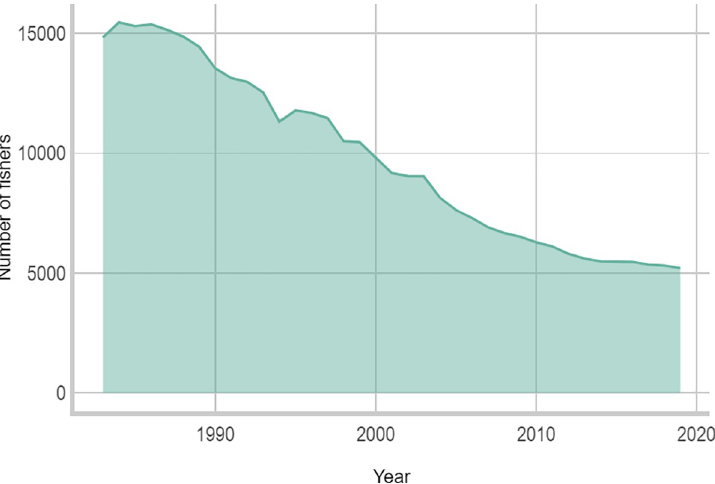
Fig 2. Number of fishers. The number of registered fishers in Northern-Norway (1983–2019) (Data source: The Norwegian Fisheries Directorate).